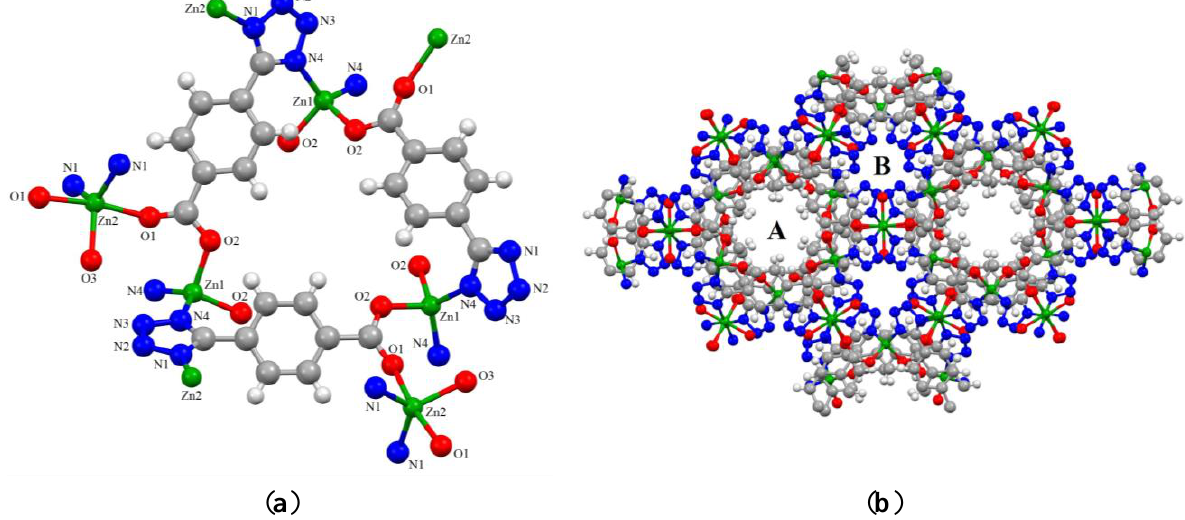
Figure 4. ( a ) The coordination modes of 3 ; ( b ) The channel structures in 3 . Symmetry